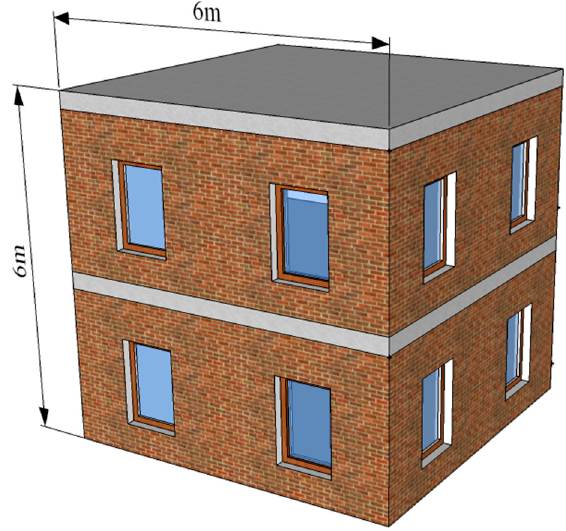
Figure 2. Simplified illustration of the simulated building.